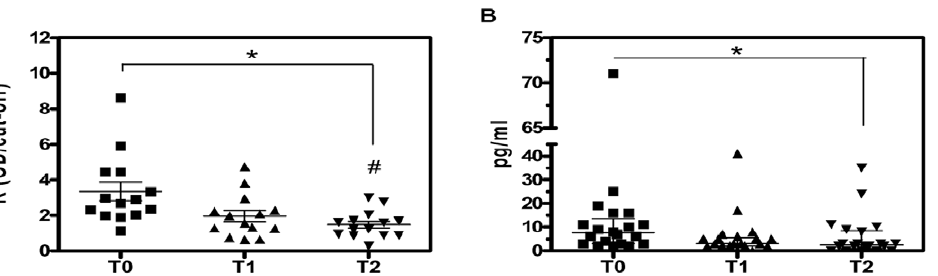
Figure 2. Anti-M2R AAb and IFN- c profiles in pediatric chagasic patients before and after BZ treatment. (A) Distribution of anti-M2R AAb in sera. Each point represents one patient positive for anti-M2R AAb. The group mean and the standard error of the mean are also depicted.